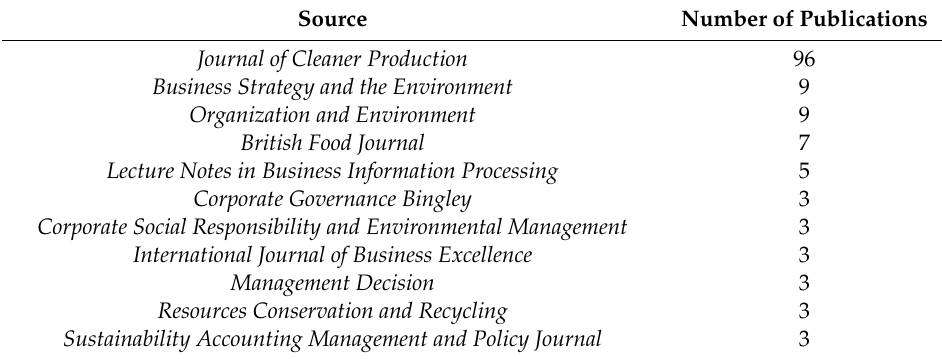
Top journals publishing papers in sustainable business models research indexed in Business , Management and Accounting and Economics , Econometrics and Finance subject areas by number of publications.